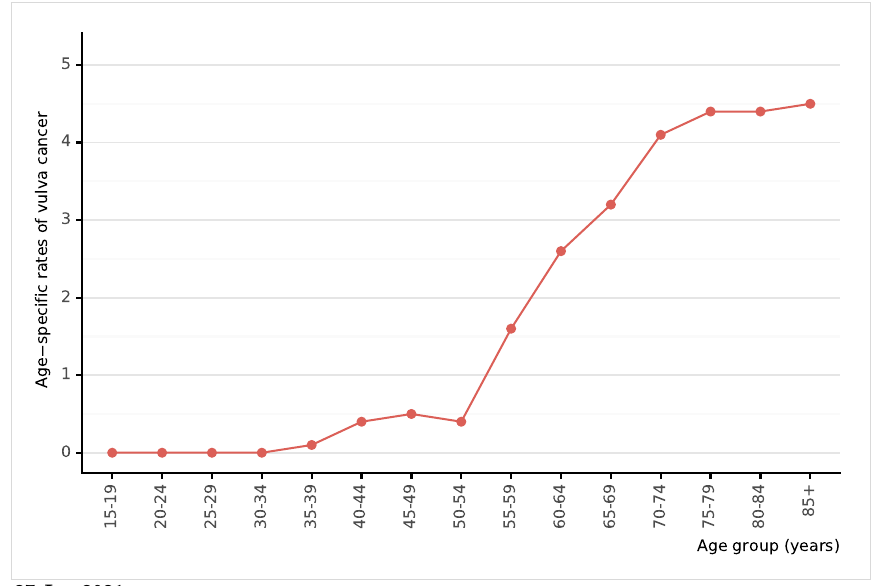
Figure 21: Age-specific incidence rates of vulva cancer in India (estimates for 2020)